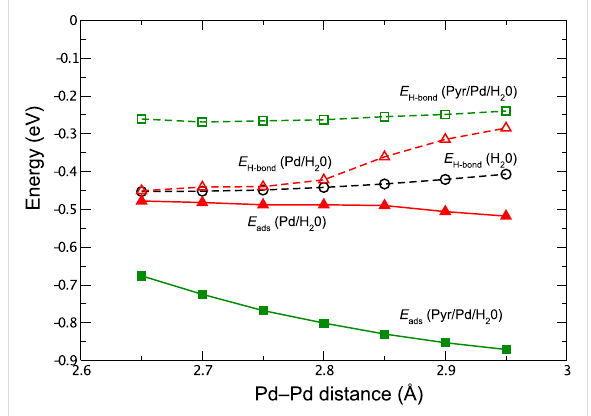
Figure 3: Adsorption energies E ads of the water bilayer together with the contribution originating entirely from H-bonds E H–bond obtained within a (3 × 3) unit cell as a function of the Pd–Pd distance from 2.65 Å to 2.95 Å, which are the nearest-neighbor distances in a free Pd monolayer and in bulk Au, respectively. The latter value has been used in the calculations of the full junction. Water in the bilayer structure is adsorbed on the (3 × 3) Pd monolayer without (Pd/H 2 O) and in the presence of pyridine molecules attached to the bottom side of the Pd layer (Pyr/Pd/H 2 O). The H-bond energy contribution of a free-standing H 2 O bilayer (H 2 O) without Pd was added as a